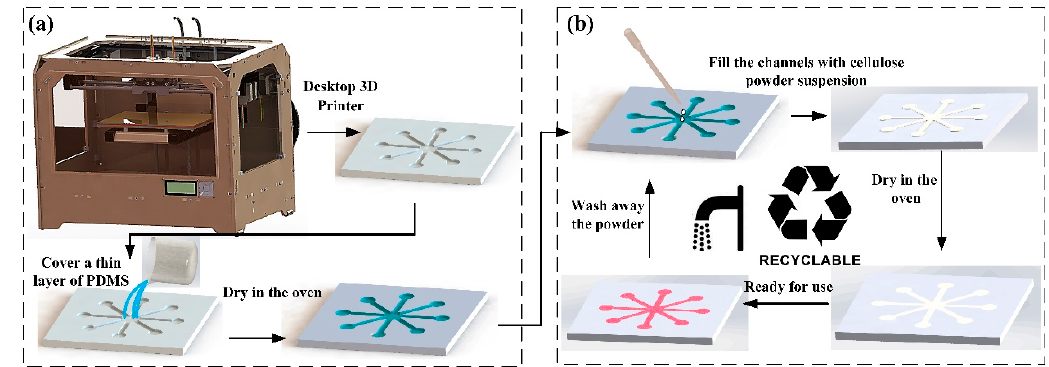
Figure 1. Fabrication process of microfluidic analytical device: ( a ) Substrate fabrication process; ( b ) Recyclable fabrication process of the hydrophilic cellulose powder channels.